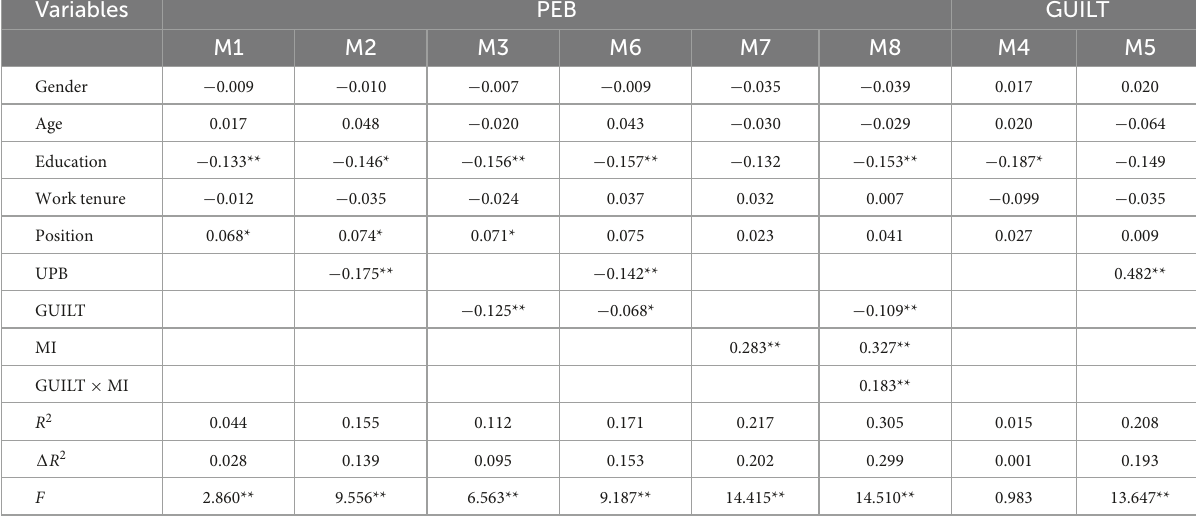
TABLE 5 Result of hierarchical regression